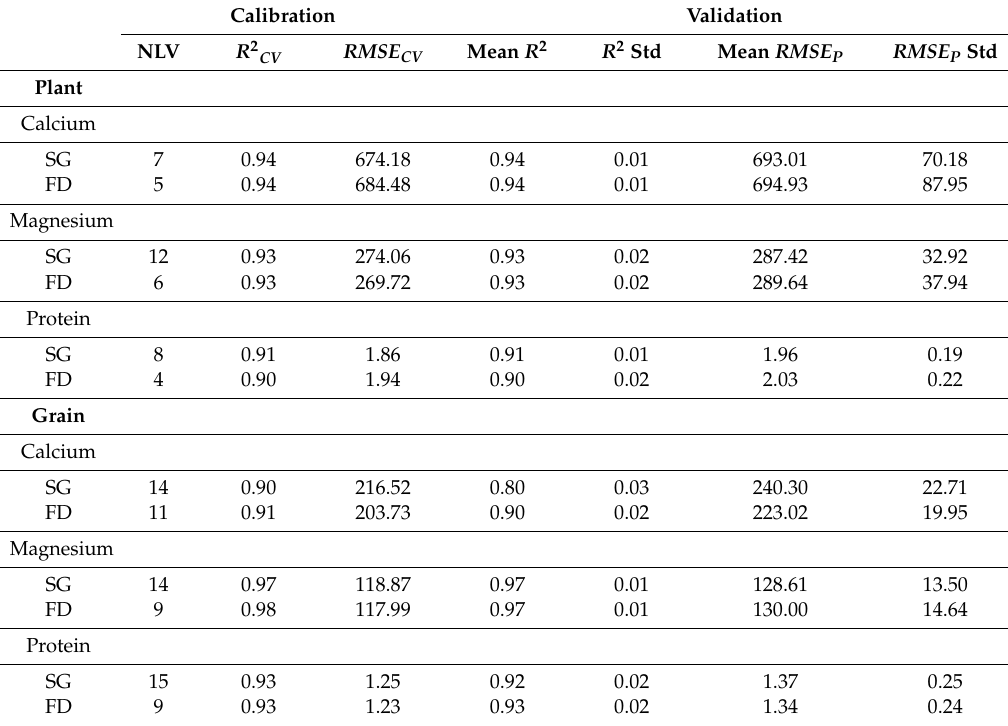
Table 6. Partial least squares regression (PLS) results for the full spectrum model (PLS-Full) for plant and grain using the combined United States and Ethiopia (USET) dataset. SG: Savitsky–Golay; FD: First derivative; NLV: Number of latent variables; std: Standard deviation.